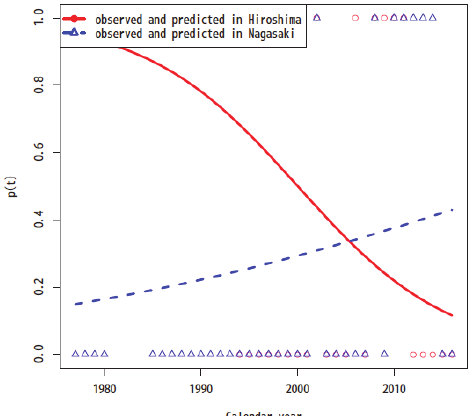
Fig. 13. Observed and predicted probability of appearance for "State"